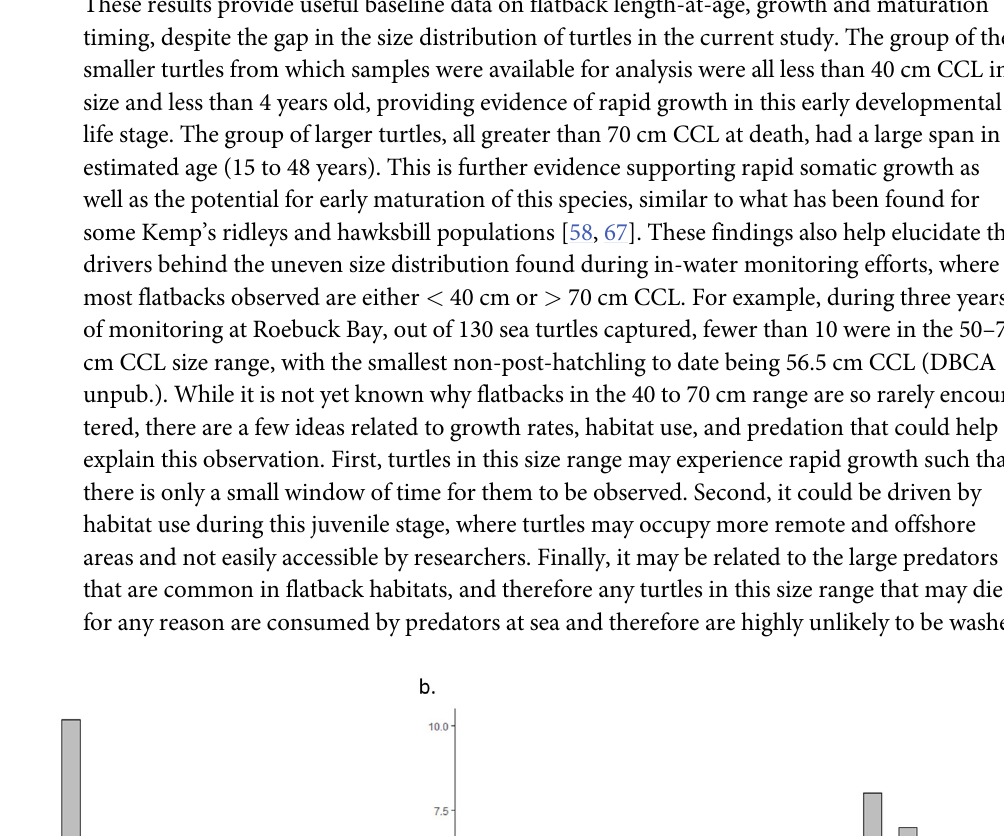
Bertalanffy growth curve using growth increments and estimated CCL. See Methods for details. c) size and age of turtles separated by geographic regions, Eastern Australia, Northern Territory, and Western Australia, to show samples collected at each location.